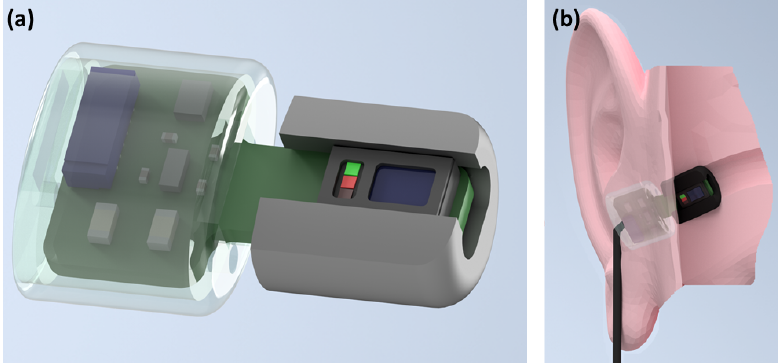
Figure 1. The in-ear photoplethysmography sensor used in our study. ( a ) Wearable in-ear photoplethysmography sensor for pulse oximetry, with a trimmed memory foam earbud and a 3D printed case to house the circuitry. ( b ) The sensor placed within the ear